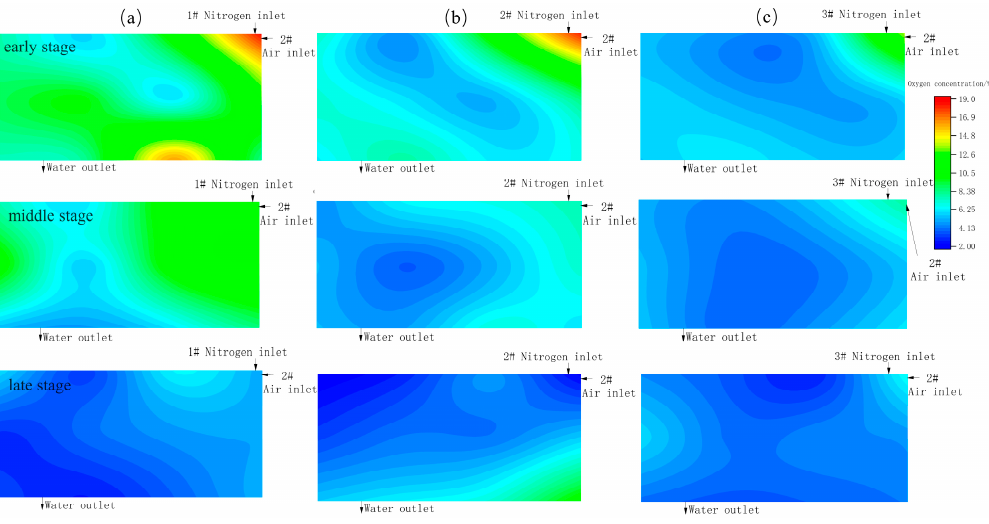
Figure 8. Change characteristics of SC hazardous area in the goaf under different nitrogen injection positions. ( a ) 1# nitrogen injection, ( b ) 2# nitrogen injection, ( c ) 3# nitrogen injection.